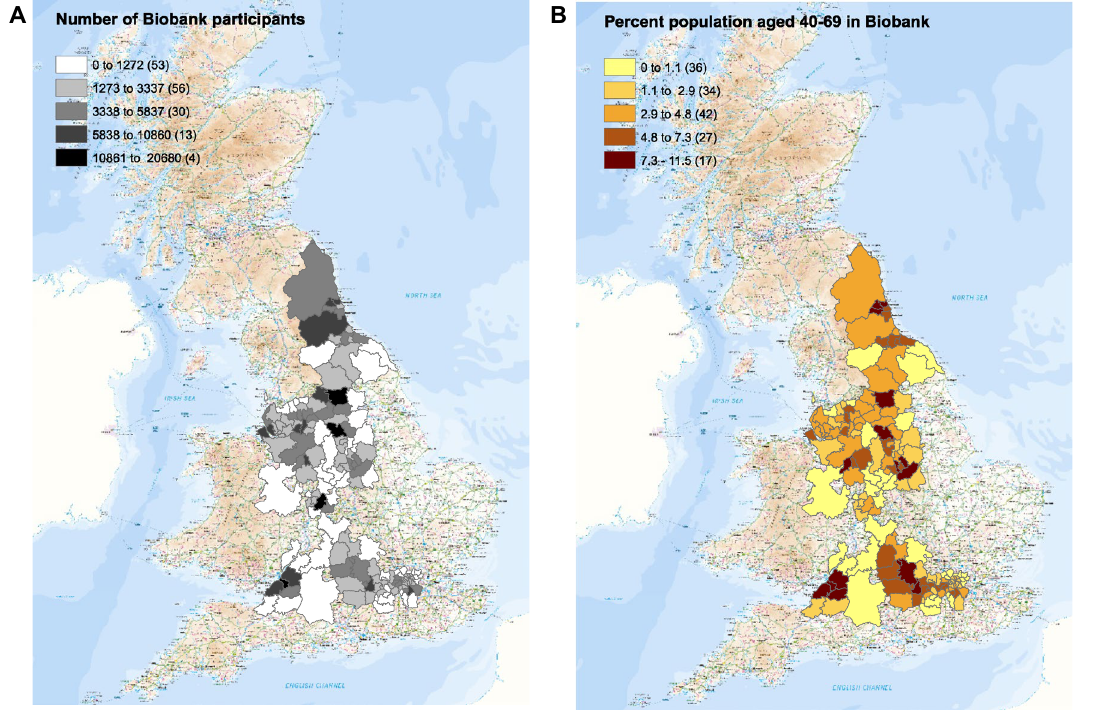
Figure 1. The numbers of UK Biobank participants identified in each local authority in which recruitment occurred (left), and the percentage of the population in each local authority recruited (right). Maps were made with ARCGIS by